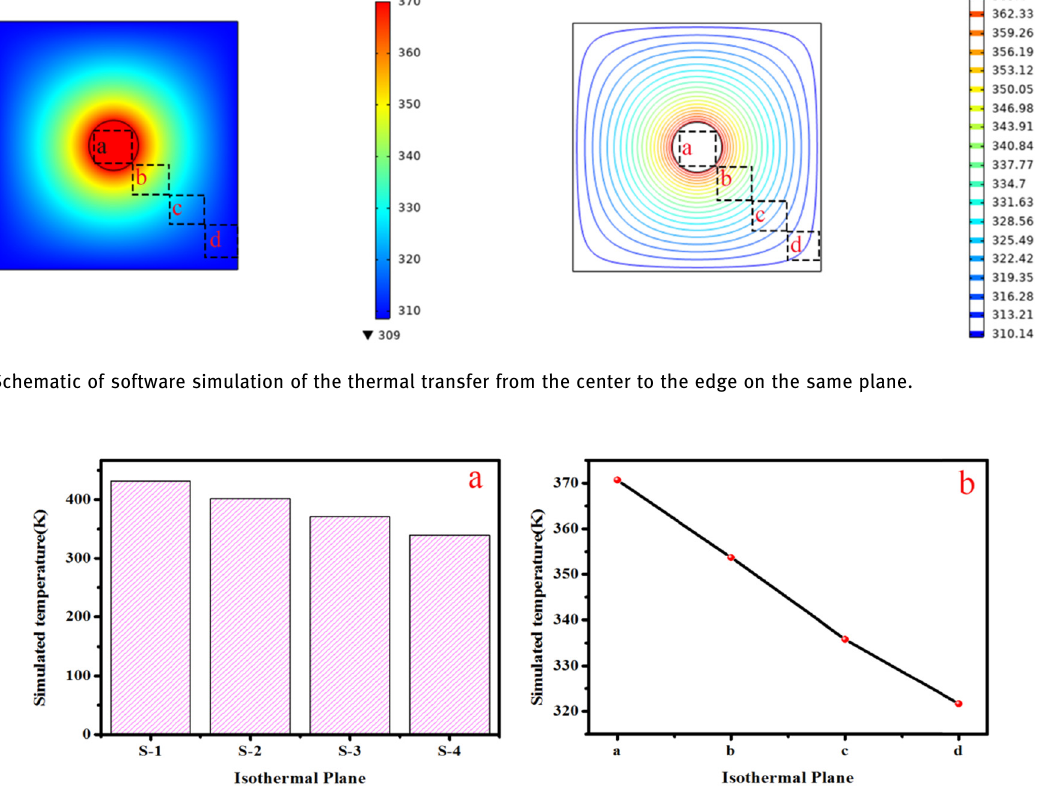
Figure 8: Simulation of the thermal transfer direction inside the PP: ( a ) di ff erent isothermal planes and ( b ) di ff erent regions of the same isothermal